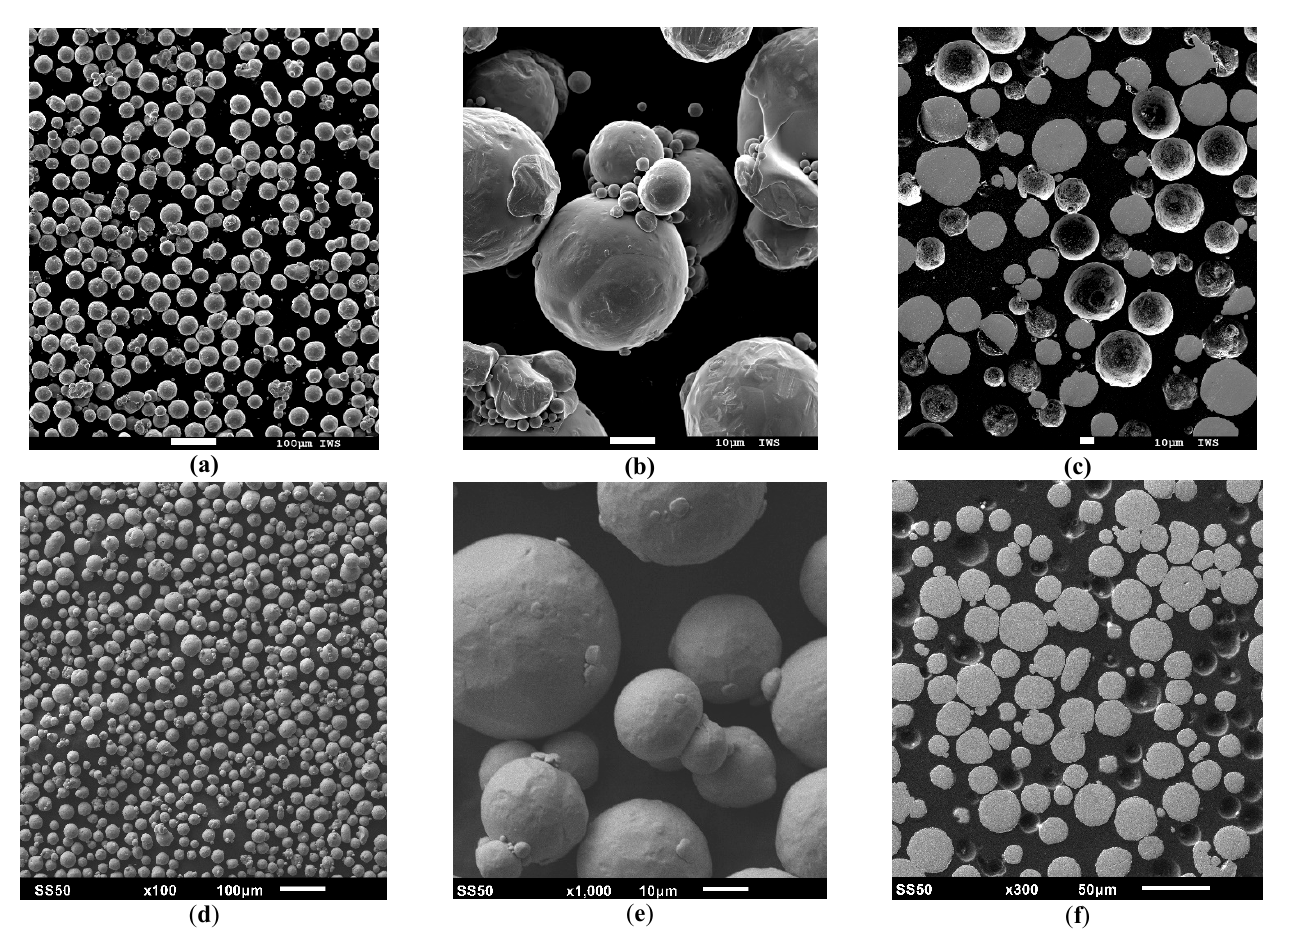
Figure 5. SEM images of loose Cu-OFHC powder at ( a ) 100× magnification, ( b ) 1000× magnification, and ( c ) embedded 300× magnification; SEM images of loose Cu-ETP powder at ( d ) 100× magnification, ( e ) 1000× magnification, and ( f ) embedded 300× magnification.